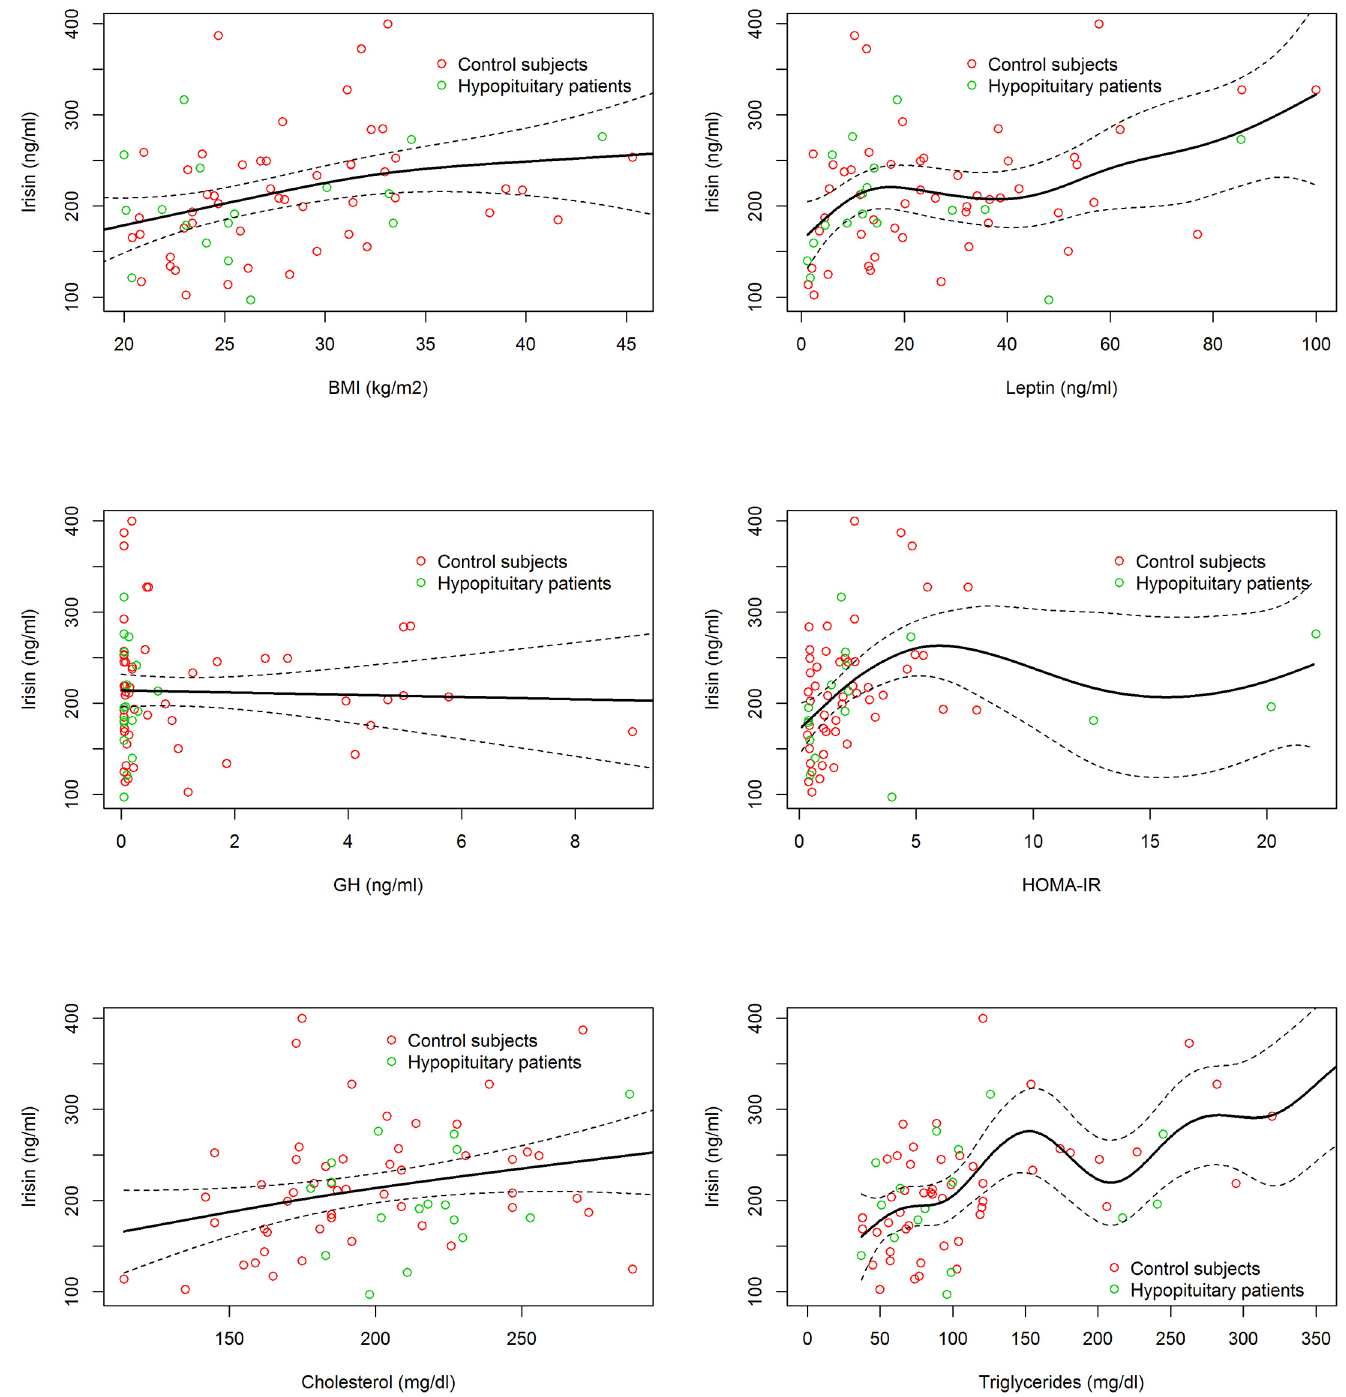
Fig 1. Relationship between Irisin and other parameters by penalized regression splines. Univariate generalized additive regression (GAM) models.